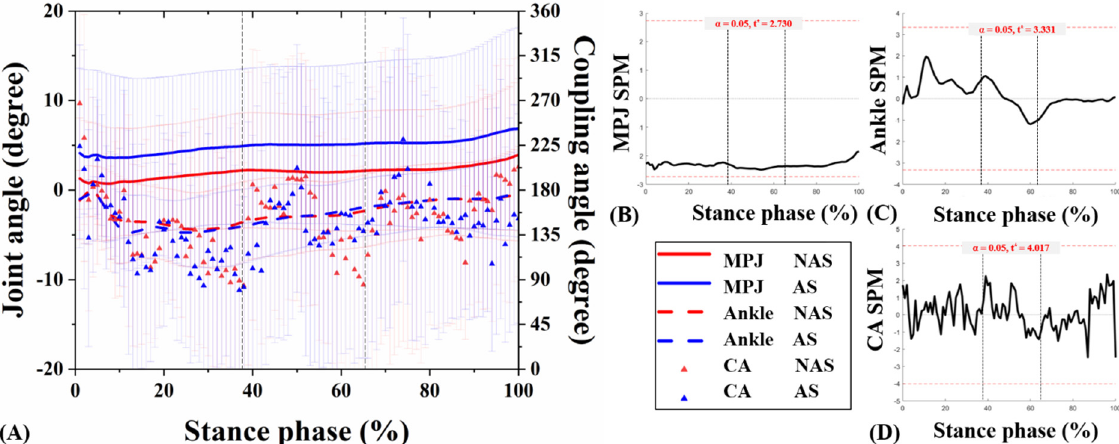
Figure 6. Angles curves of the ankle and MPJ, and mean CA for MPJ-ankle in the transverse plane ( A ). The SPM results between NAS and AS during UGT, depicting the MPJ angle ( B ), ankle angle ( C ), and CA ( D ).